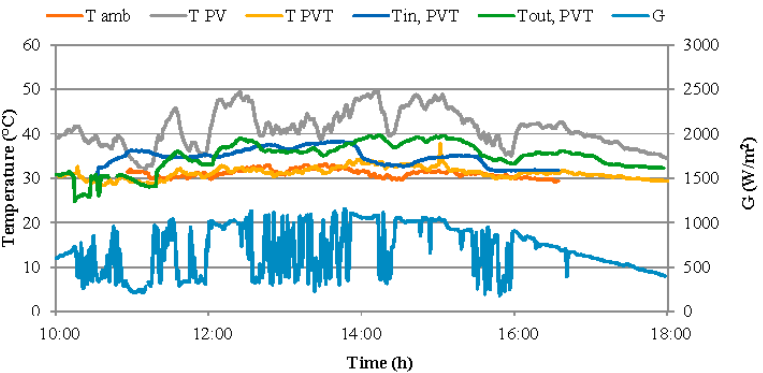
Figure 11. Ambient temperature, PVT and PV temperature, total radiation.